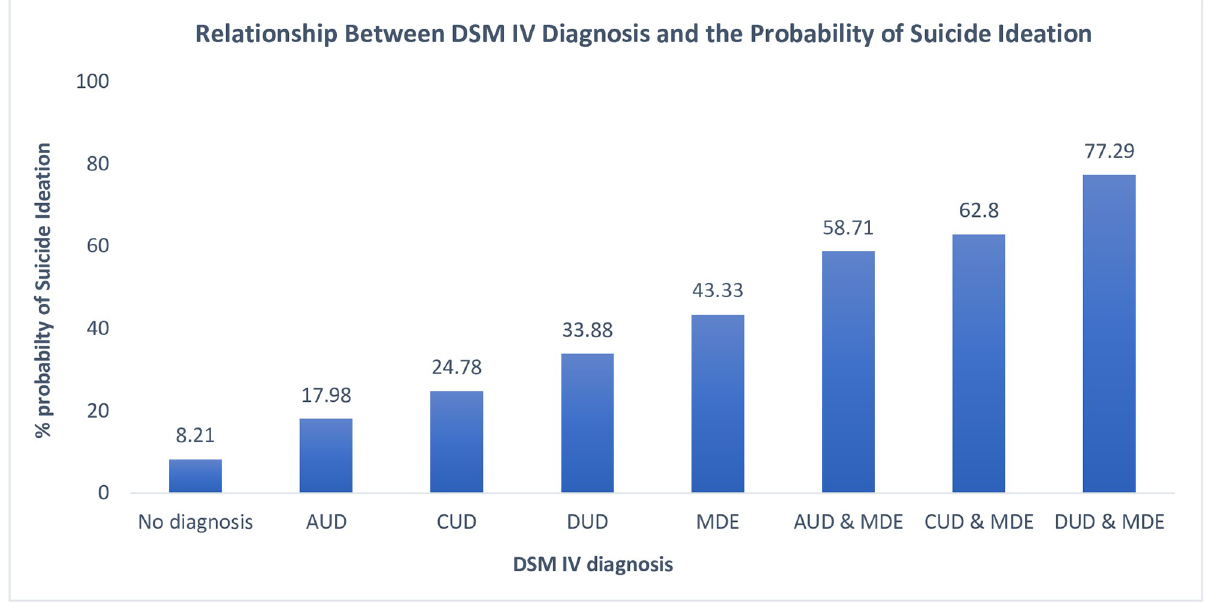
Fig 2. Relationship between lifetime DSM-IV diagnosis and the probability of lifetime suicide ideation. AUD—Alcohol use disorder, defined DSM-IV Alcohol Abuse /or Dependence diagnoses.; CUD—Cannabis use disorder, defined DSM-IV Cannabis Abuse /or Dependence diagnoses; DUD —Drug use disorder, defined as DSM-IV diagnoses of drug abuse/or dependence diagnoses on opiates, sedatives, tranquilizers, amphetamines hallucinogens, heroin, cocaine, inhalants, and/or other drug except cannabis.; MDE—Major depressive episode, defined DSM-IV diagnosis of major depressive